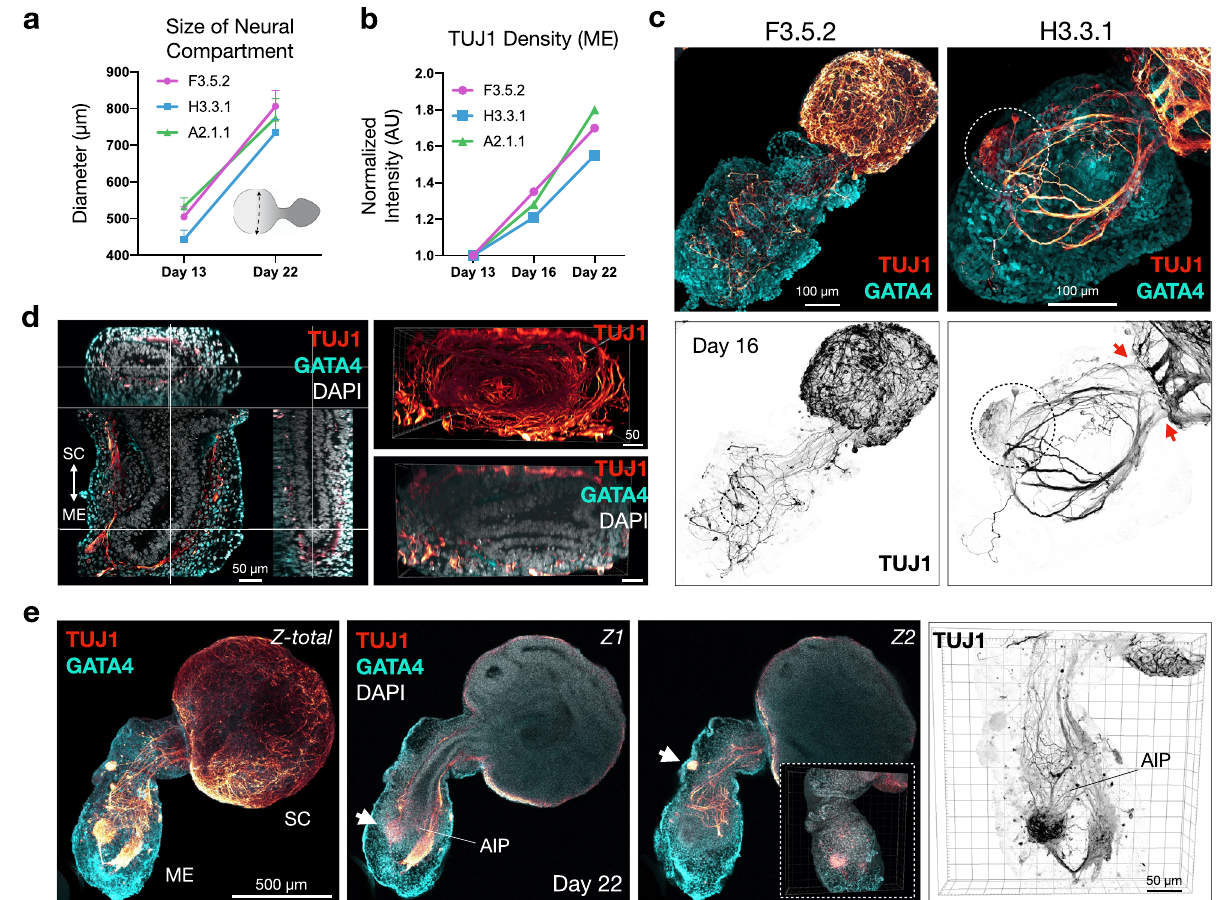
Fig. 5 Neuronal cytoarchitectures are reproducibly patterned in close relationship to the gut tube. a Change in diameter of spinal cord (SC) compartment from days 13 to 22 ( n = 47 EMLOs measured per line). b Change in TUJ1 density by normalized fl uorescence of Z-stack volumes between days 13, 16, and 22 ( n = 3 EMLOs per time point per line). c TUJ1 (red) and GATA4 (cyan) IF of F3.5.2 and H3.3.1 day 16 EMLOs. Peripheral ganglion formation (dotted circle) and neuronal bottleneck (red arrows) are appreciated. ImageJ inverted LUT (TUJ1) was used for black and white images. d Multi- dimensional visualization of gut tube-neuron interaction in H3.3.1 day 16 EMLO. Sagittal and transverse planes of gut tube subsumed by neural processes (left); end-on view of neuronal tunnel (TUJ1 + , top) about gut tube (DAPI, bottom). e TUJ1/GATA4 of H3.3.1 day 22 EMLO. Maximally projected Z-stack (left, Z-total) is shown with two Z-slices (Z1, Z2). SC and ME labeled for orientation. Peripheral ganglia form in close proximity to gut tube anterior intestinal portal-like (AIP) region. Z2 inset depicts 3D undulating GATA4 exterior with interpenetrating neurons. High magni fi cation TUJ1 reconstruction shown (right). For IF, GATA4 and TUJ1 staining was performed in each of the N = 11 H3.3.1 EMLO formation experiments with similar results c – e . Individual scale bars provided. Data reported as (mean